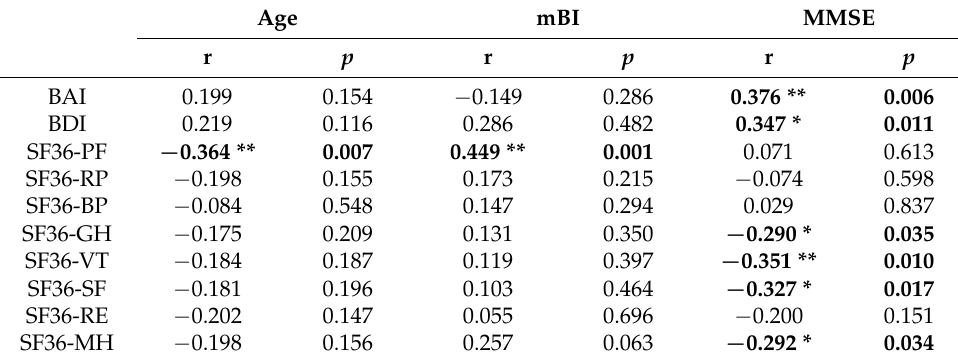
Table 1. Correlations between anxiety, depression, and Quality of Life with age, disability, and cognitive function. mBI: Modified Barthel Index; MMSE: Mini-Mental State Examination; SF36: Short Form 36; BAI: Beck anxiety inventory; BDI: Beck depression inventory; PF: Physical Functioning; RP: Role-functioning Physical; BP: Bodily Pain; GH: General Health; VT: Vitality; SF: Social Functioning; RE: Role-functioning Emotional; MH: Mental Health. Values in bold indicate statistically significant correlations (* p < 0.05; ** p < 0.01). Age mBI